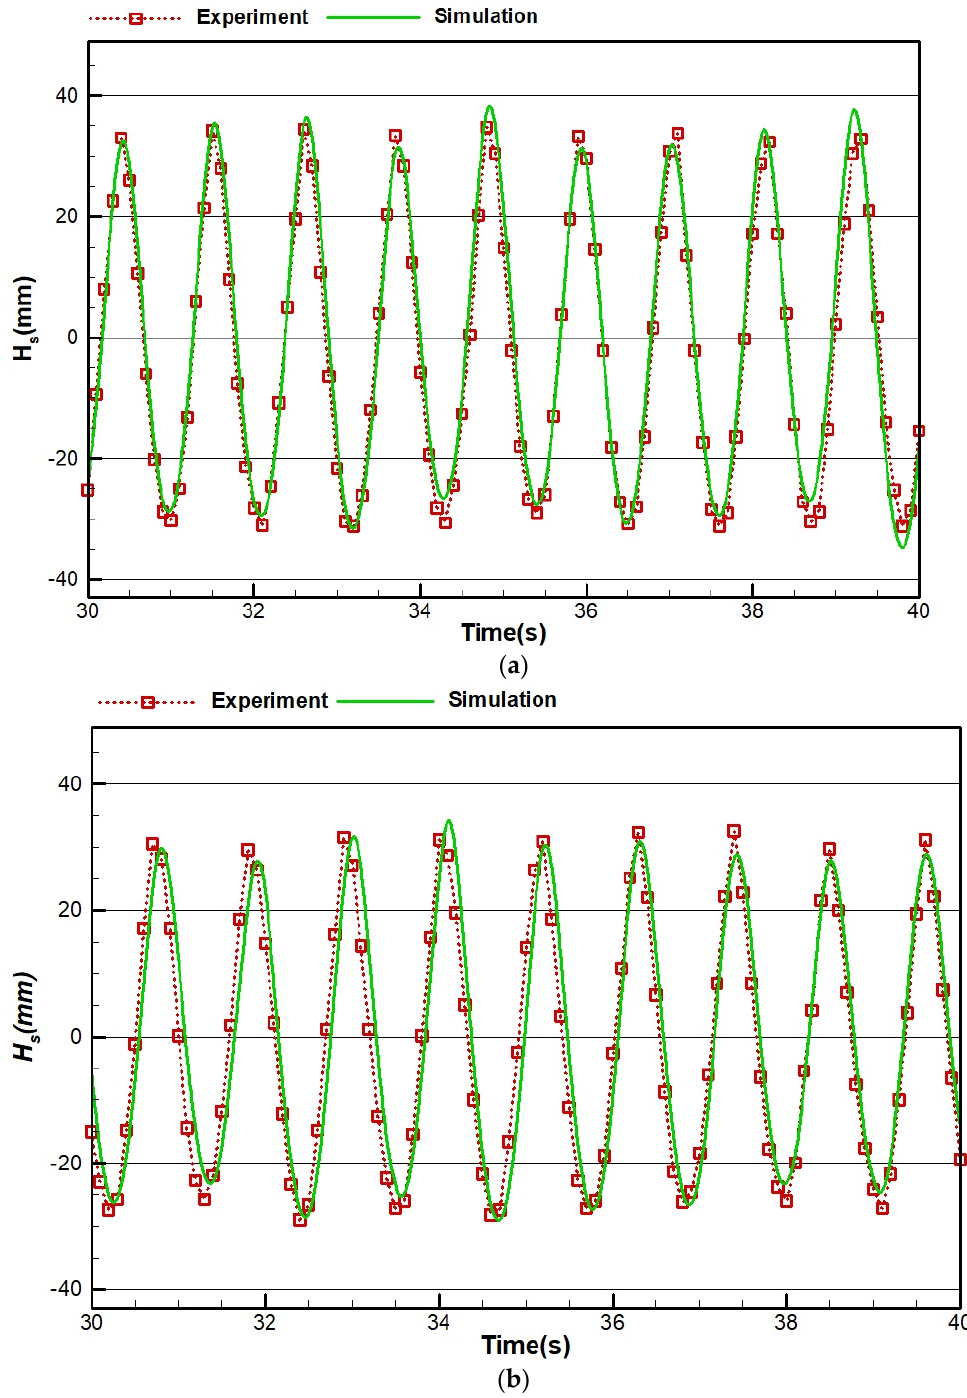
Figure 19. Wave height of case 2 at a distance of ( a ) 3 m and ( b ) 5 m from the flap.